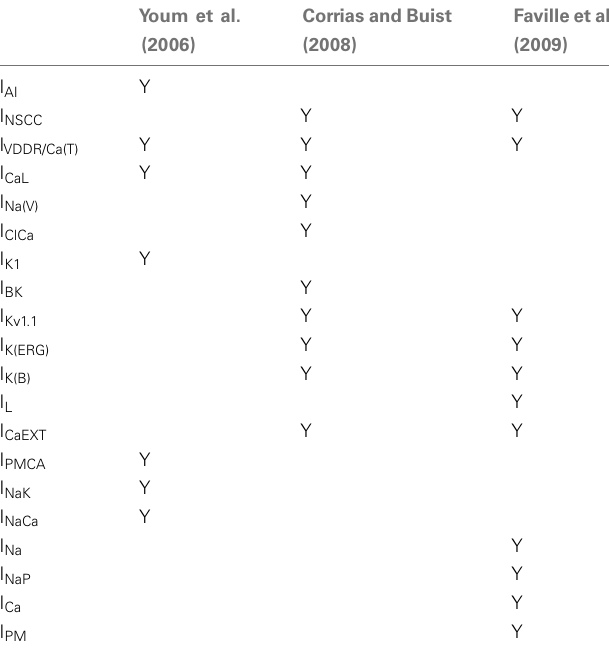
Table 2 | A comparison of the different types of ion conductances and intracellular components in the three ICC models (Youm et al., 2006; Corrias and Buist, 2008; Faville et al.,